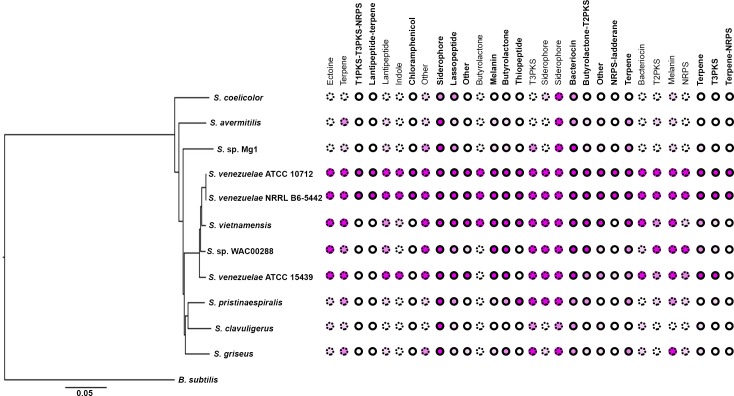
Conservation of specialized metabolic clusters in diverse streptomycetes.Phylogenetic tree of diverse Streptomyces species, with the relative conservation of each specialized metabolic cluster from S. venezuelae shown in the right. Conservation is based on BLAST analyses, with <20% (white), 20% (light pink), 40% (medium pink) and 60% (dark pink) indicating query coverage and overall degree of cluster conservation. Clusters bound by Lsr2 are indicated with bolded names and solid circles, while those not bound by Lsr2 are depicted with dotted circles.